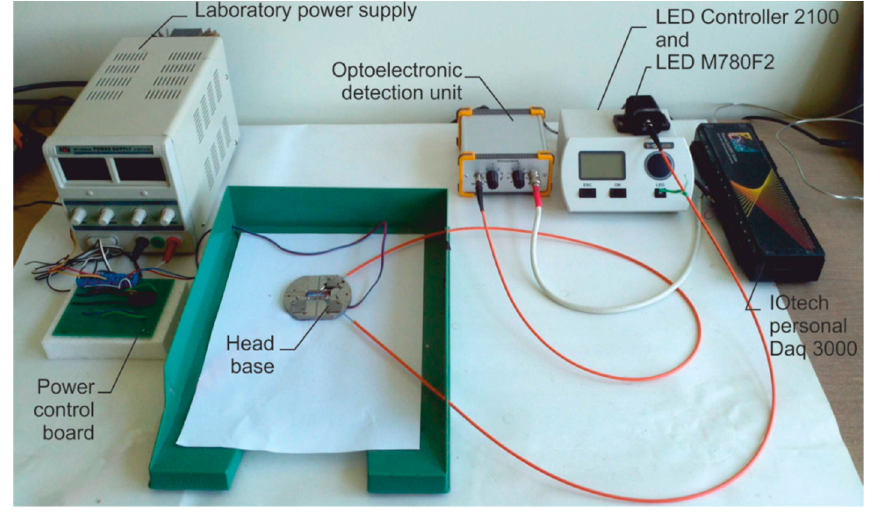
Figure 3. Examined sensor view, based on [40].